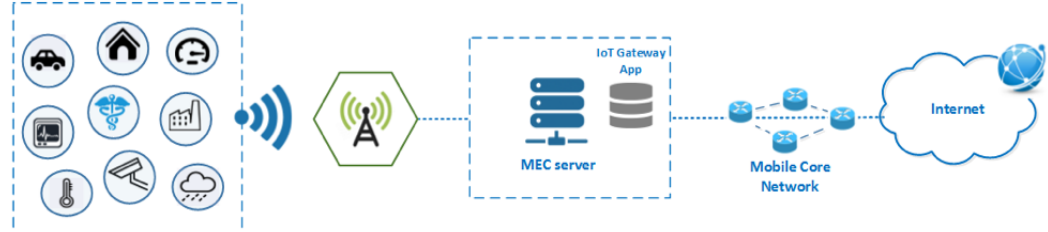
Figure 1. European Telecommunications Standards Institute (ETSI) use case blueprint in which a Multi-access Edge Computing (MEC) node is deployed as the IoT